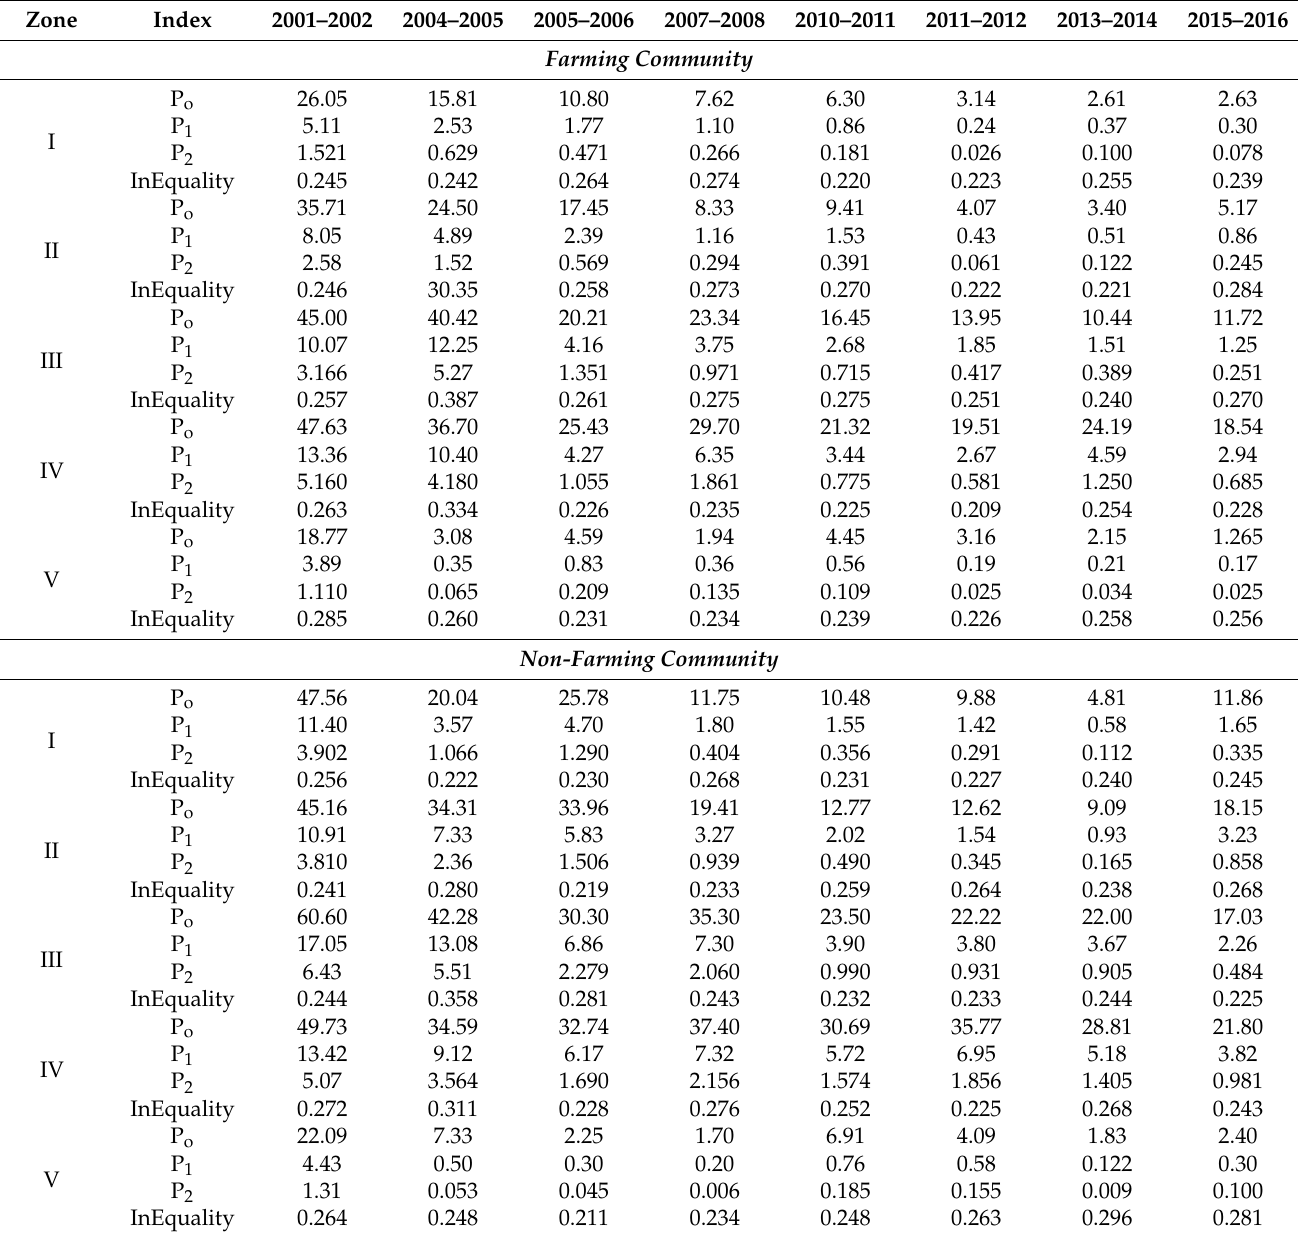
Table 1. Poverty and inequality across agro-climatic zones in